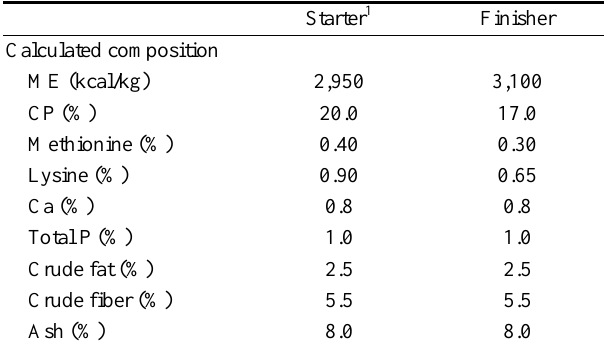
Table 1. Calculated chemical composition of experimental diet (as-fed basis) Starter 1 Finisher